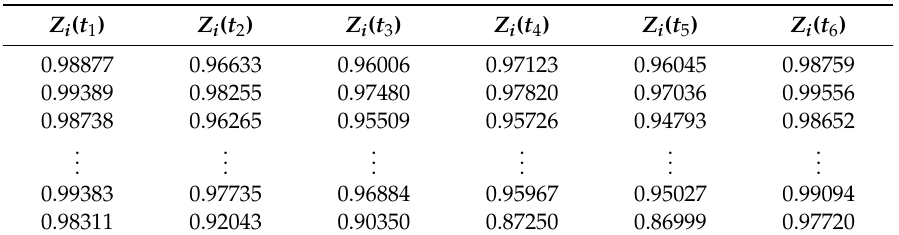
Table 11. The DEC value (unit: mm).